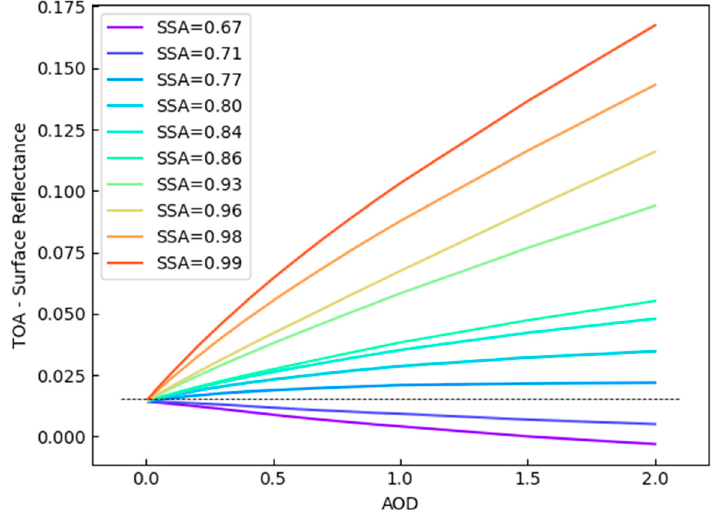
Figure 3. Relationship between the TOA-surface reflectance (the difference between TOA reflectance and surface reflectance) and AOD under different SSA conditions (surface reflectance = ◦ , sensor zenith angle = 0 ◦ , relative azimuth angle = 160 ◦ 0.1, solar zenith angle = 0°, sensor zenith angle = 0°, relative azimuth angle = 160°). lar zenith angle = 0